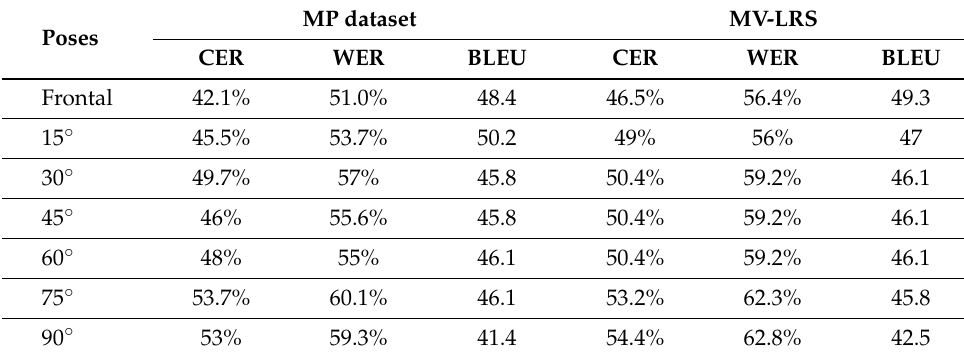
Table 3. Performance measure of two datasets for all possible poses.